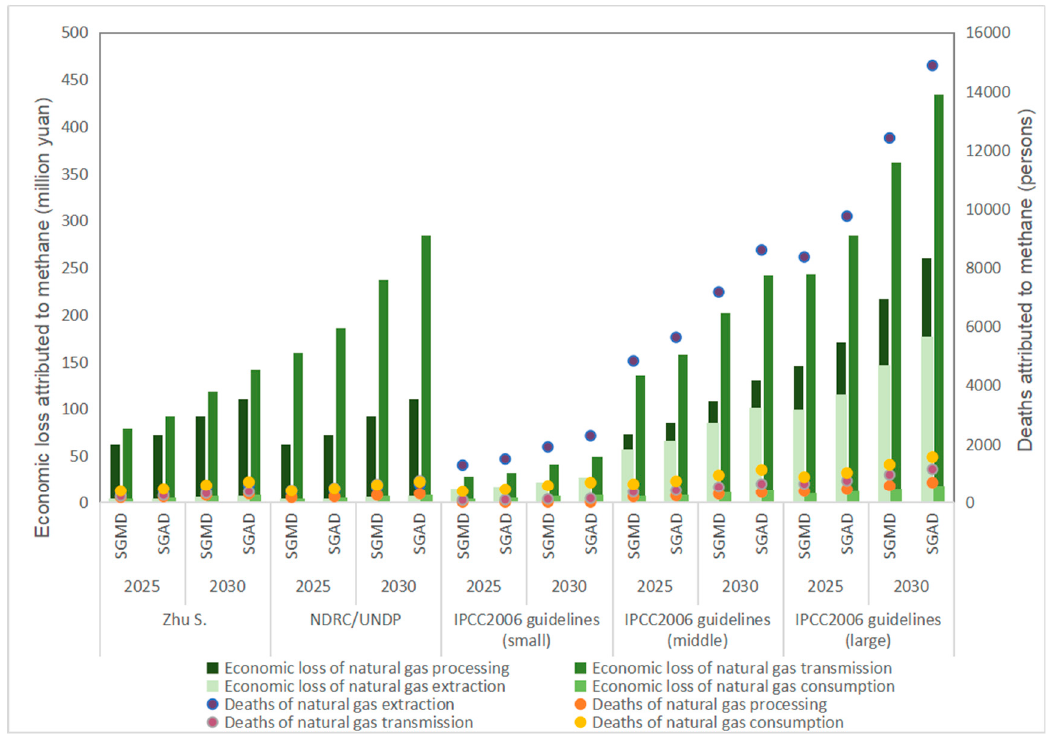
Figure 12. Number of deaths and economic loss attributed to